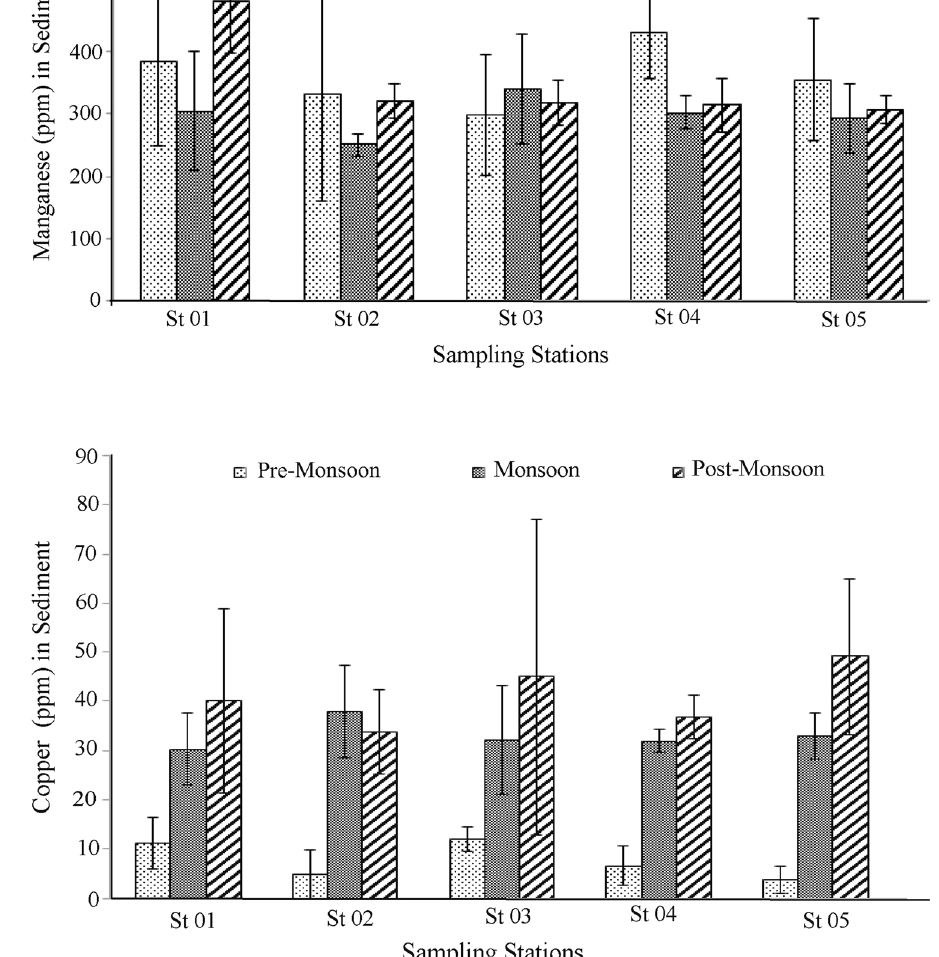
Fig. 4 Sediment manganese concentration (± SD) variation at different seasons in differ- ent sampling stations of Sundar- ban mangrove estuary